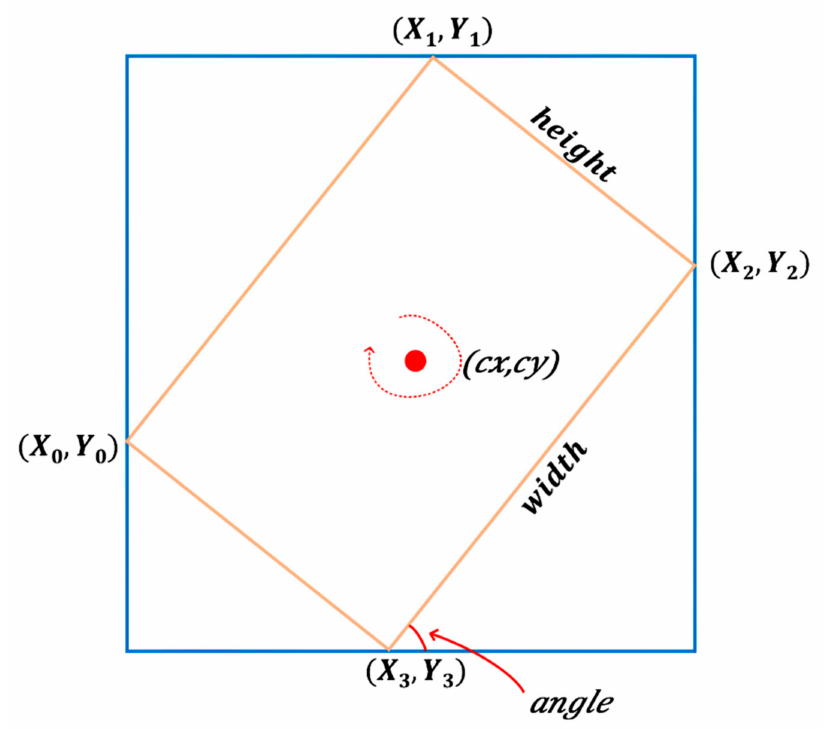
Figure 8. The definition diagram of the rotating box. height and width respectively represent the length and width of the image, with the horizontal to the right as the positive direction. Take the point ( X 3 , Y 3 ) in the lower-left corner as the starting point, and rotate clockwise around the center point ( cy , cx ).